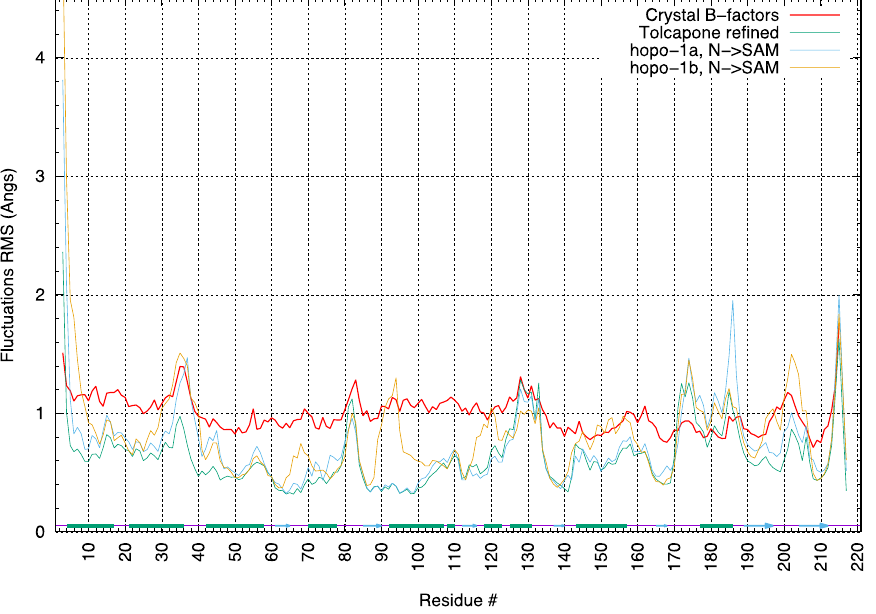
Figure 8. Backbone RMSF calculated from the MD simulations and compared to those calculated from the crystal structure of COMT in complex with tolcapone. Table 5. Relative Binding Free Energy